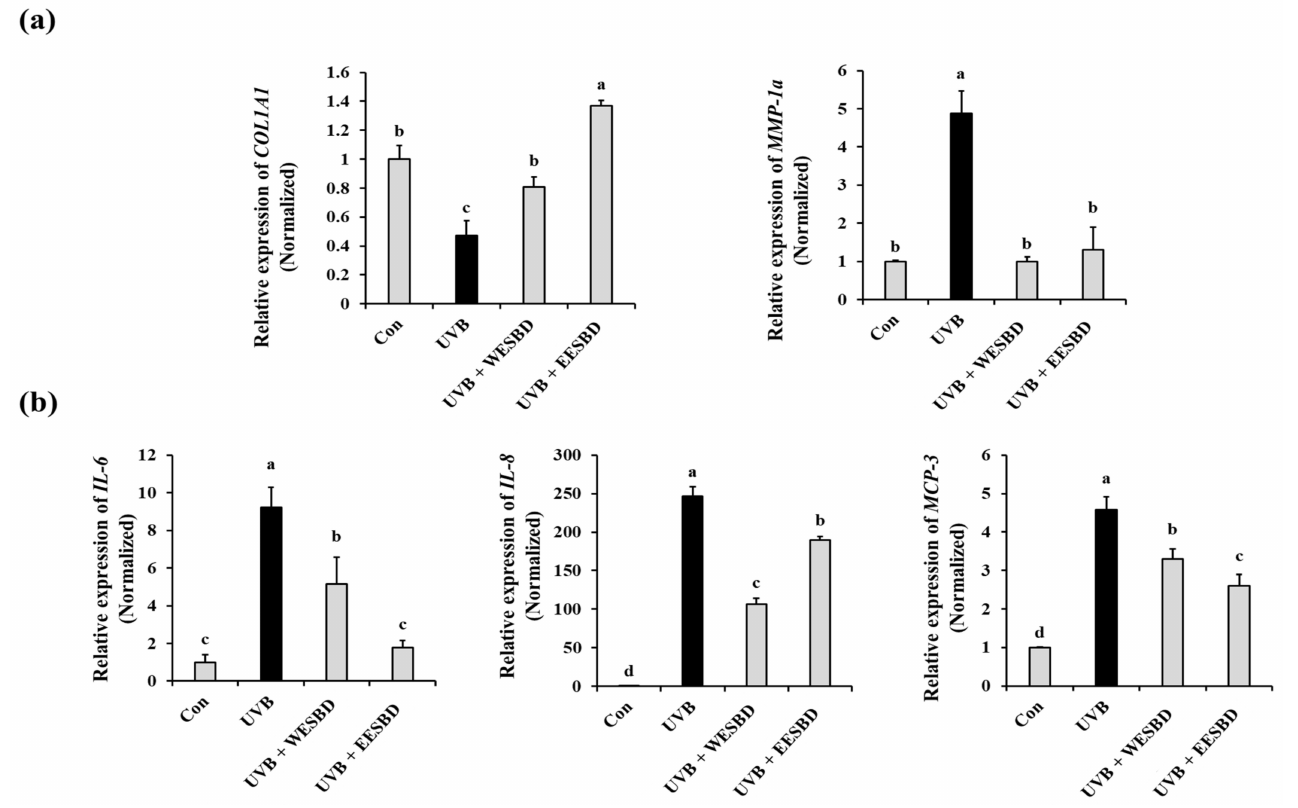
Figure 2. Effect of water extract of S. barbata D. Don (WESBD) and ethanol extract of SBD (EESBD) treatments on the expression of photoaging-related gene expression induced by ultraviolet B (UVB) irradiation. Pretreatment with WESBD (50 µ g/mL) or EESBD (10 µ g/mL) eliminated abnormal expression of type-1 procollagen (COL1A1) ( a ), metalloproteinase-1a (MMP-1a) ( a ), IL-6 ( b ), IL-8 ( b ), and MCP-3 ( b ) induced by UVB irradiation in NIH-3T3 cells. The expression of these genes was determined by quantitative real-time PCR (qRT-PCR) and normalized to that of the glyceraldehyde 3-phosphate dehydrogenase ( GAPDH ) gene. The experiments were repeated three times, with similar results. A representative result is shown. Data are presented as the mean ± SD. Different letters indicate a significant difference between groups ( p <